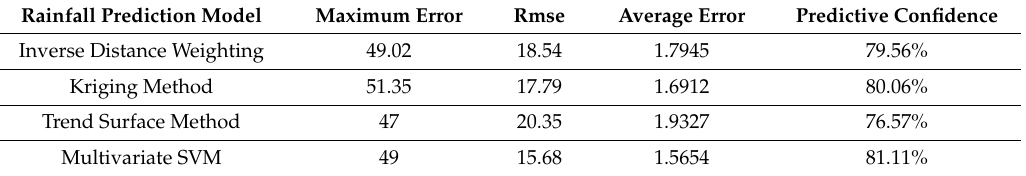
Table 4. Comparison of original spatial interpolation methods and multivariate SVM.